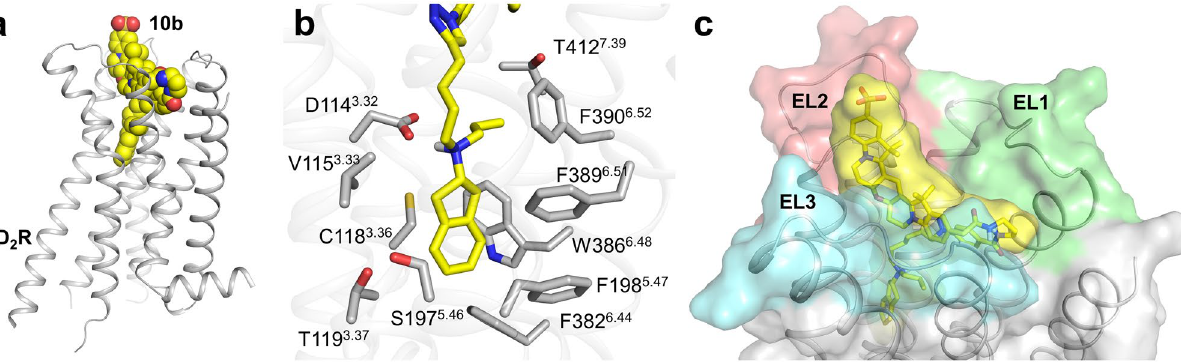
Figure 2. Docking pose of 10b at D 2 R. ( a ) Overview of the 10b pose in the D 2 R. ( b ) The stick representation of the indanylamine pharmacophore in the orthosteric binding pocket shows an ionic interaction of the protonated nitrogen with D114 3.32 , while the aromatic ringsystem is accommodated in a hydrophobic pocket formed by V115 3.33 , C118 3.36 , T119 3.37 , S197 5.46 , F198 5.47 , F382 6.44 , W386 6.48 and F389 6.51 . The propyl substituent of the protonated amine points into a hydrophobic cleft formed by W386 6.48 , F390 6.52 and T412 7.39 . ( c ) Surface representation of the extracellular loop region. 10b is colored yellow, while EL1, EL2 and EL3 are colored in green, red and cyan, respectively. The polar sulfonate group of 10b is directed outwards towards the solvent.